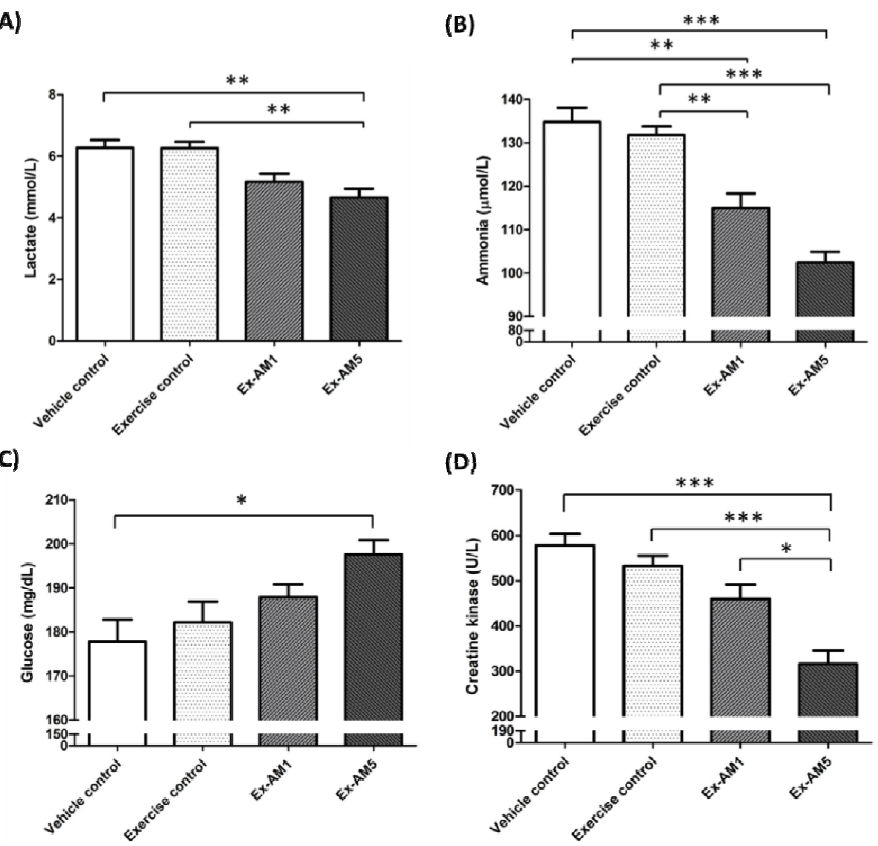
Figure 2. Effect of AM supplementation on serum lactate ( A ), ammonia ( B ), glucose ( C ), and CK ( D ) levels after a 15-min swim test without weight loading. Data are mean ± SEM of n = 10 mice in each group by one-way ANOVA. Different letters indicate a